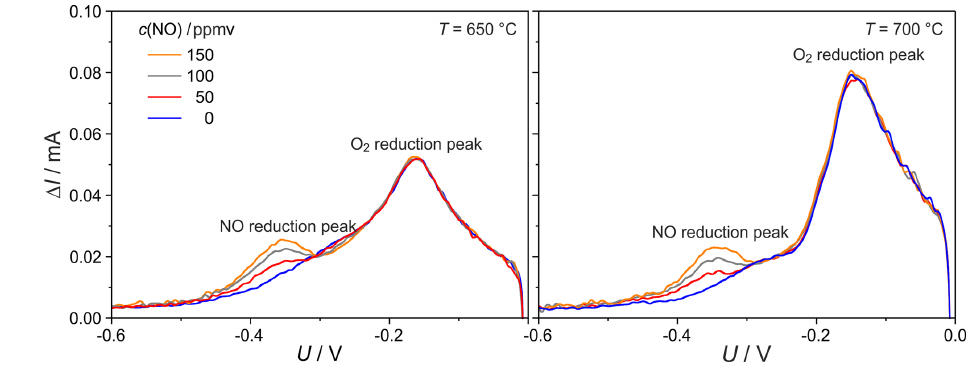
Figure 9. SWV at different temperatures and different NO concentrations. f SWV = 5Hz; other experimental conditions as declared in Fig. 8.